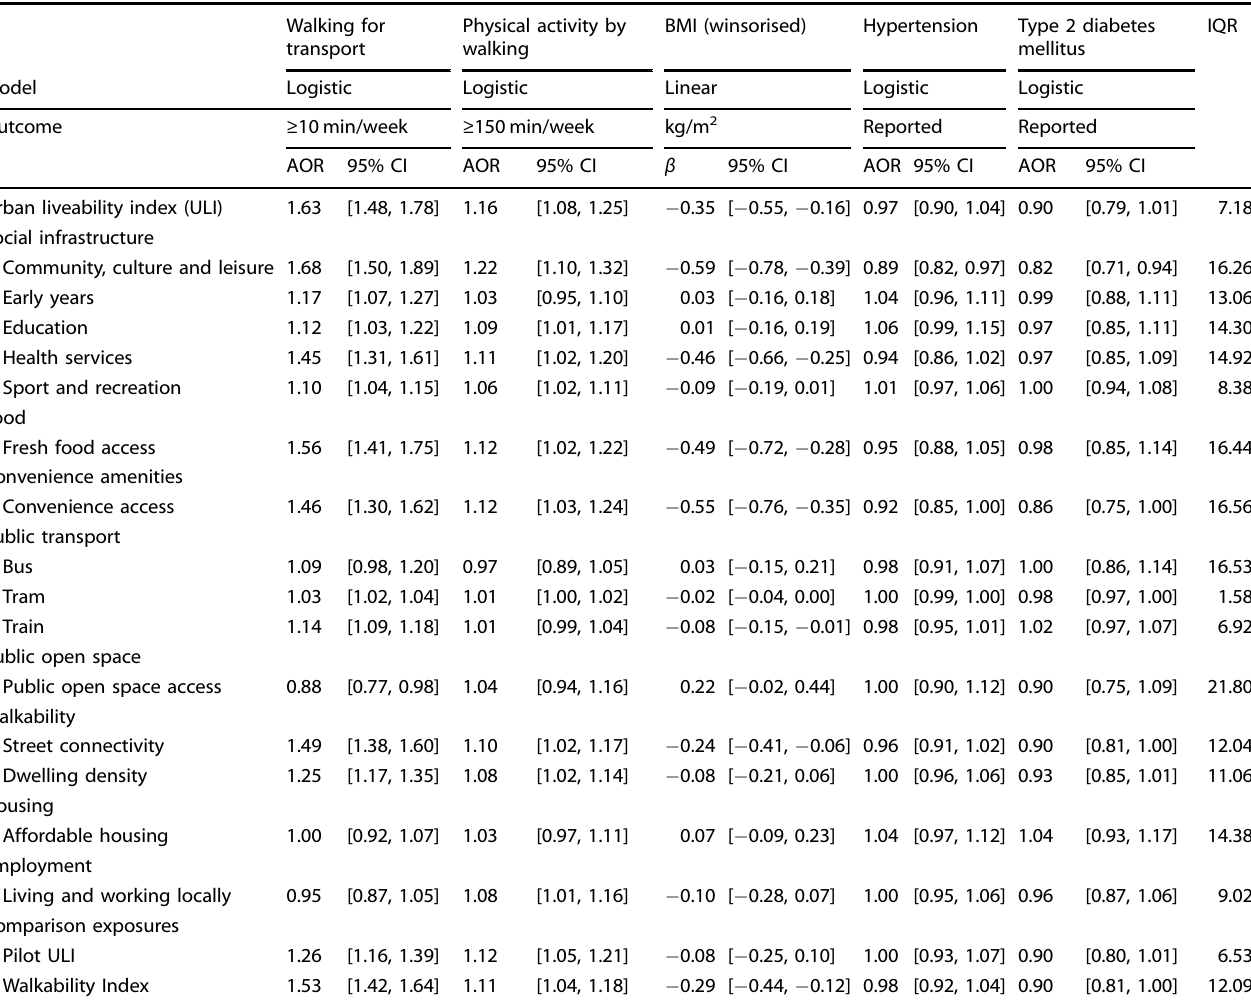
Table 3. Estimated effect sizes of urban liveability index on physical activity and cardiometabolic risk factors outcomes (Analyses 1 – 5) per interquartile range increase in